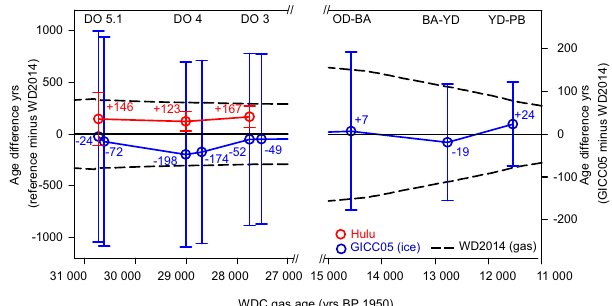
Figure 10. Comparison between WD2014 and two independently dated records from the Northern Hemisphere. Age differences are shown between WD2014 and GICC05 (NGRIP-Project-Members, 2004) and between WD2014 and Hulu Cave (Wang et al., 2001; Buizert et al., 2015; Edwards et al., 2016) using CH 4 synchroniza- tion for time periods of rapid climate transition (i.e. NGRIP δ 18 O, Hulu δ 18 O calcite ) between 31 and 27ka (left panel) and between 15 and 11ka (right panel). We use a Greenland-CH 4 phasing of 50 ± 30 years for the YD–PB transition, 45 ± 30 years for the OD– BA transition and 25 ± 30 years for all other transitions (Rosen et al., 2014; Buizert et al., 2015). We assume no age difference be- tween Hulu and CH 4 during the transition of DO 5.1, DO 4 and DO 3. Note the different scaling of the respective y axis for the two time periods. A positive value means that the reference record is older than WD2014. Error bars represent 2 σ age uncertainties of the reference chronologies. Also shown are gas-age uncertainties (black dashed line) for WD2014 (Buizert et al.,